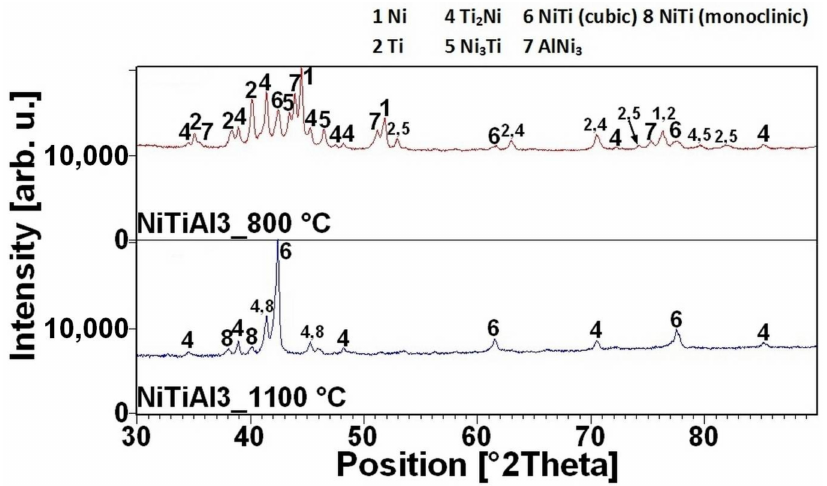
Figure 7. XRD patterns of the NiTiAl3 sample sintered at 800 and 1100 ◦ C.